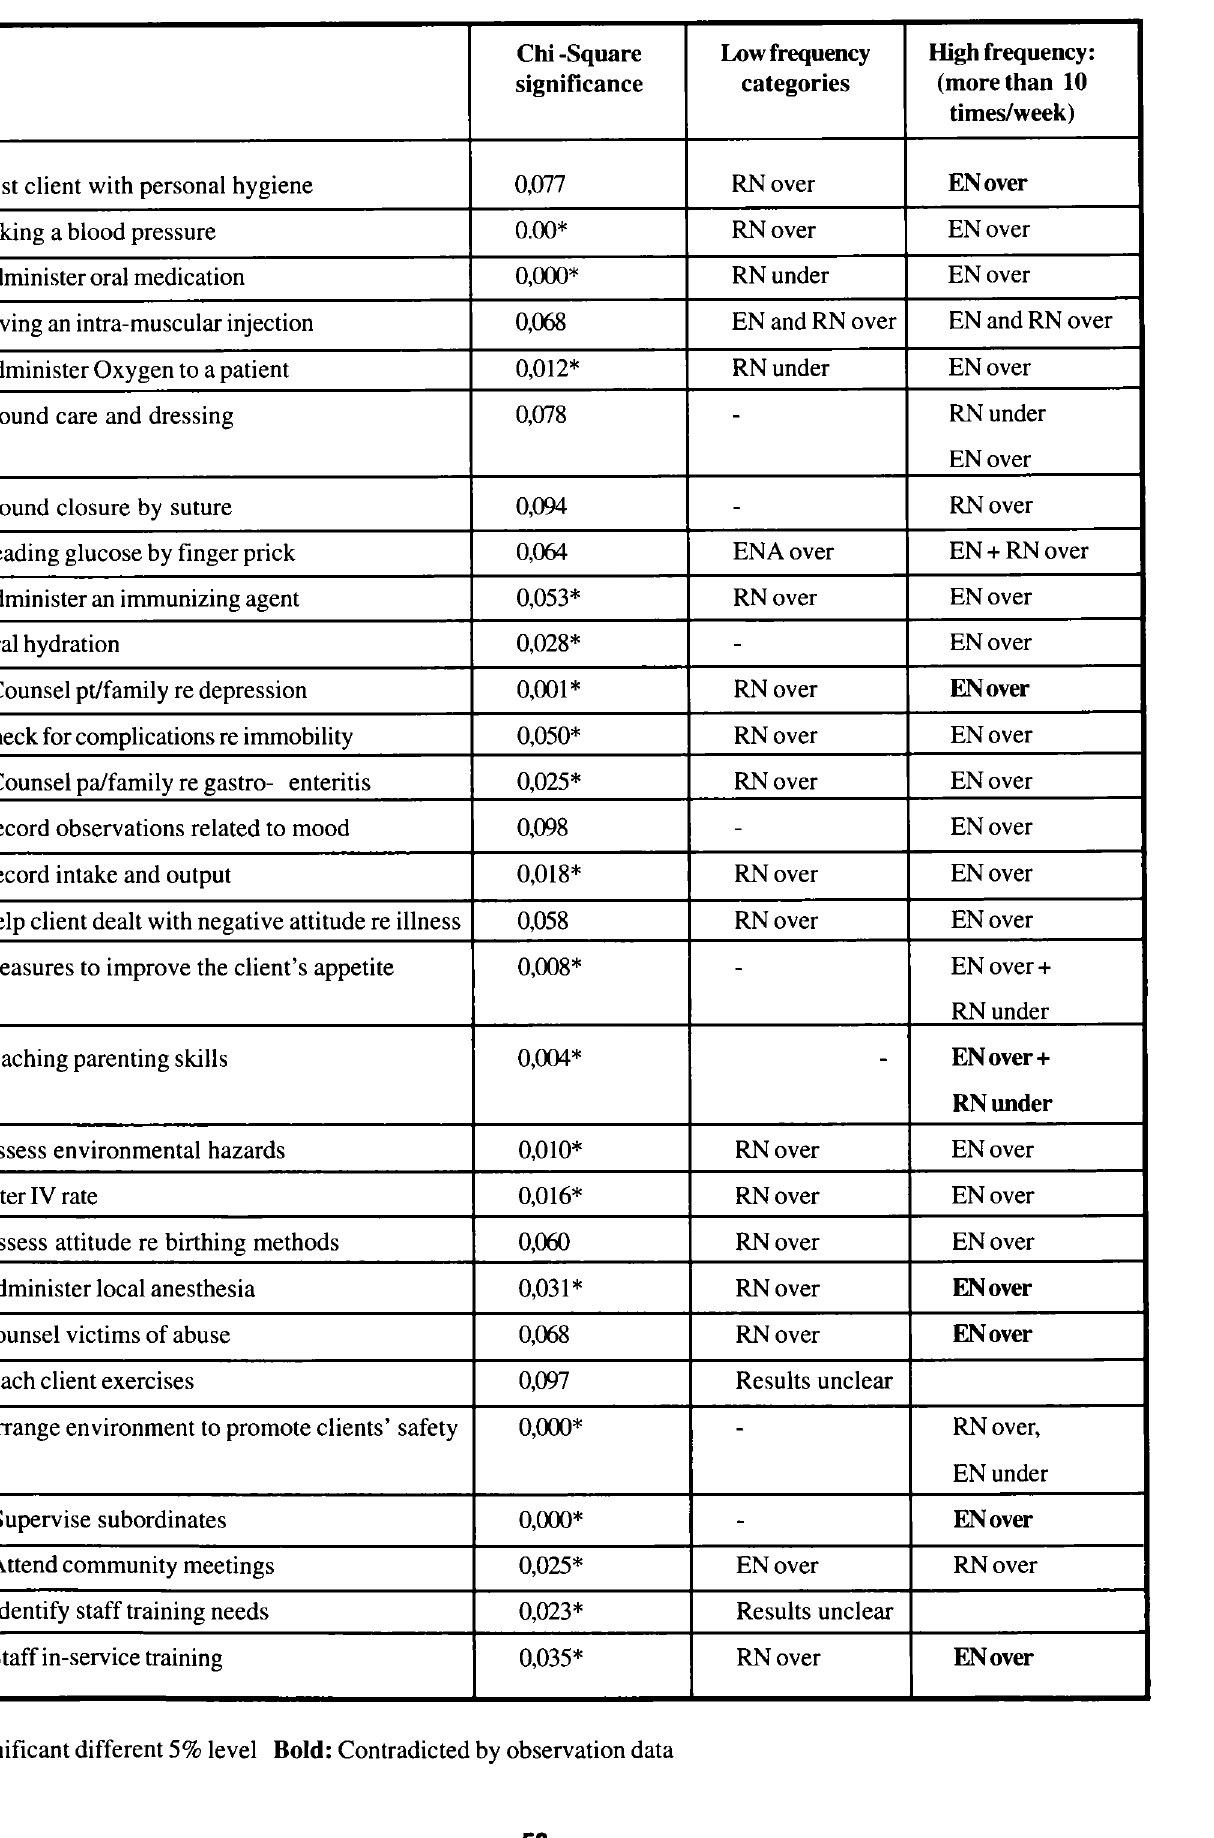
Table 2.6 Comparison of task frequency between categories of